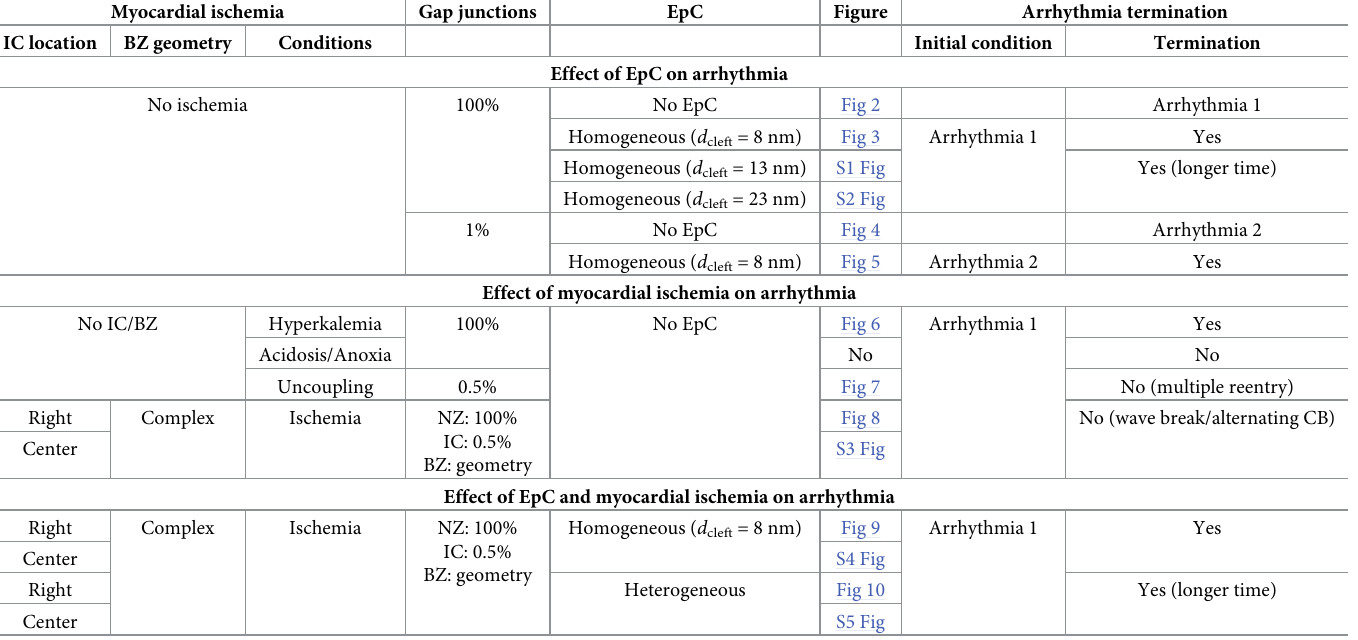
Table 1. Arrhythmia termination during acute myocardial ischemia: Role of EpC and complex geometry of BZ. Myocardial ischemia Figure